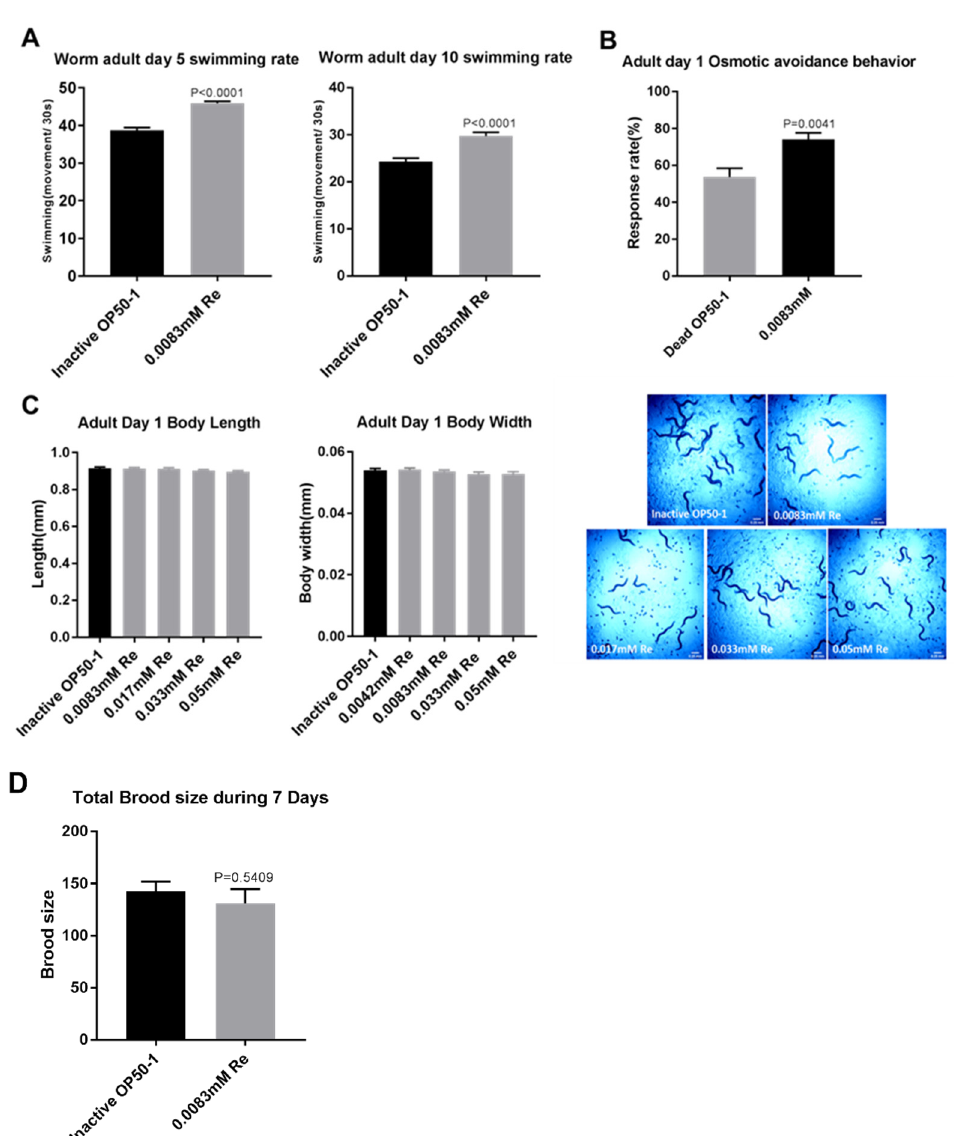
Figure 2. Reb A extends healthspan in C. elegans . ( A ) Swimming movement in C. elegans on the 5th and the 10th day of adulthood on control NGM and NGM supplemented with 0.0083 mM Reb A; ( B ) Osmotic avoidance behavior in C. elegans on the 1st day of adulthood on control NGM and NGM supplemented with 0.0083 mM Reb A. Statistical significance was calculated by unpaired t ‐ test; ( C ) Body length and width of C. elegans on the 1st day of adulthood grown on control NGM and NGM supplemented with different concentrations of Reb A. Statistical significance was calculated by Dunnet’s test; ( D ) A comparison on total brood size over a seven ‐ day reproductive period.